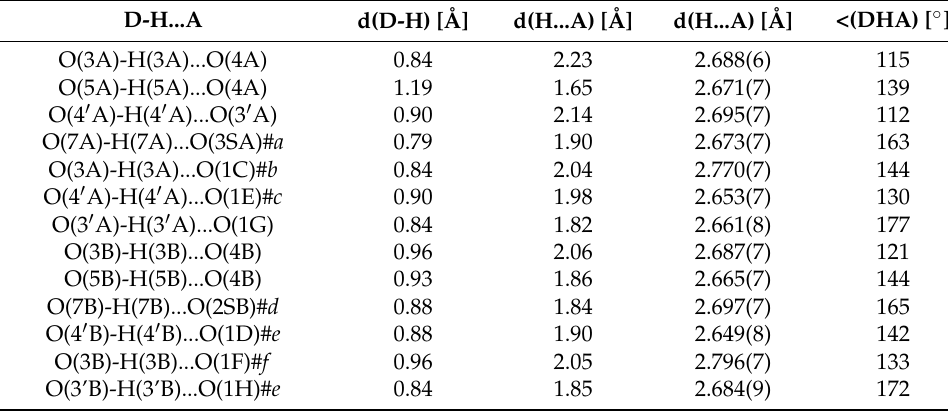
Table 7. Geometry of O-H . . . O hydrogen bonds observed in crystal 3